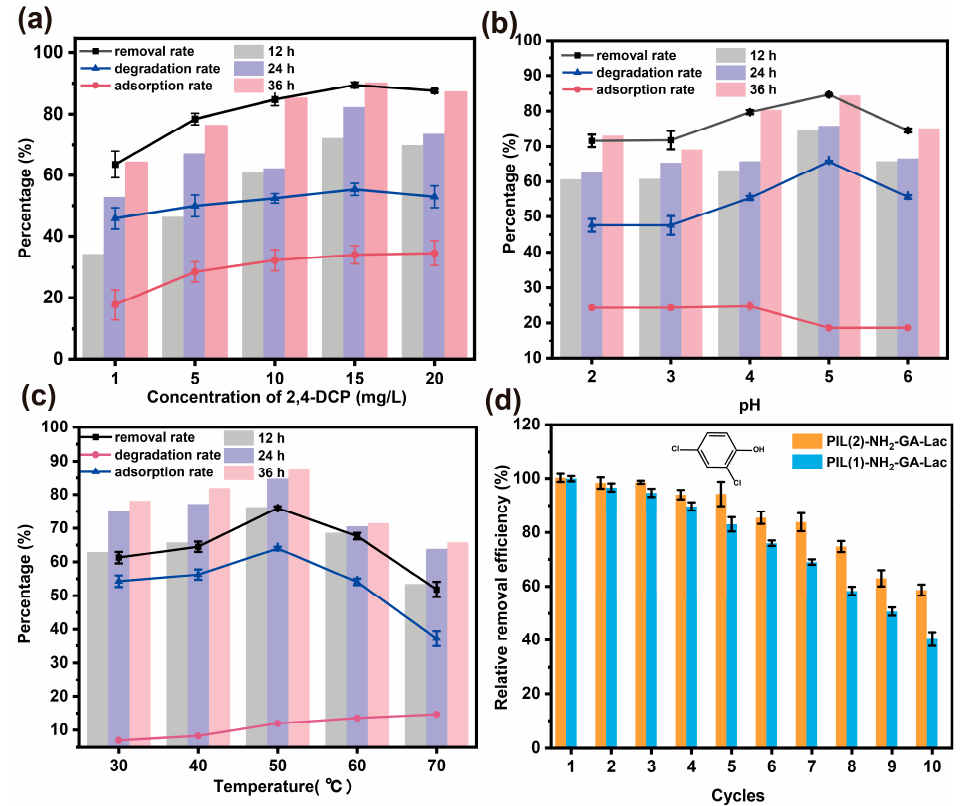
Figure 5. Effect of time and concentration of 2,4-DCP ( a ), pH ( b ), and temperature ( c ) on the efficiency of removal of phenolic compounds and reusability of the immobilized laccase ( d ). Conditions: 2,4-DCP (1 mg/L), PIL–NH 2 –GA–Lac (10 mg/mL), pH = 3 ( b – d ), 20 °C ( a , c , d ), and 12 h ( d ).